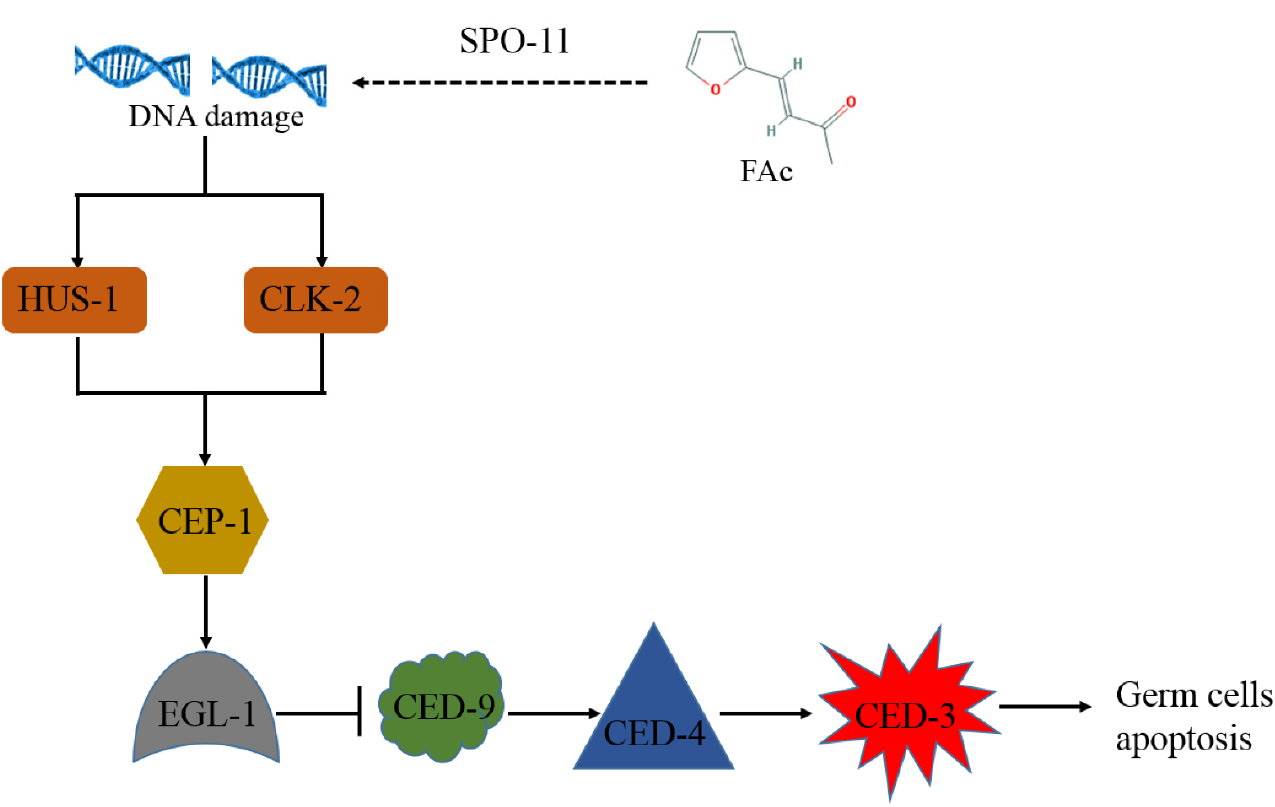
Figure 6. Schematic of model for FAc-induced apoptosis in C. elegans germ cells. Nematode exposure to FAc might lead to DNA double-strand breaks through protein SPO-11, and then the DNA damage checkpoint proteins HUS-1 and CLK-2 induce the activation of the p53-like protein CEP-1. CEP-1 regulates the apoptotic response to DNA damage during oogenesis, allowing for the transcription of egl-1. EGL-1 binds with the CED-9 and alleviates CED-9 sequestration of CED-4 to activate CED-3 caspase, leading to germ-cell